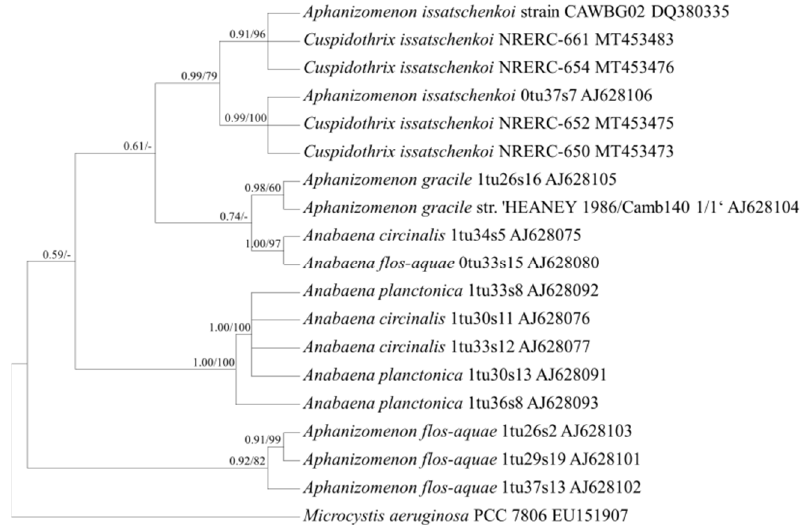
Figure 3. Consensus Bayesian tree based on aligned 499-bp sequences of rpoB using the GTR+G+I model with Microcystis aeruginosa as an outgroup. The parameters were as follows: assumed equal nucleotide frequency; substitution rate matrix with A–C substitutions = 0.0645, A–G = 0.2786, A–T = 0.0524, C–G = 0.1046, C–T = 0.4546, and G–T = 0.0451; proportion of sites assumed to be invariable = 0.2717; and rates for variable sites assumed to follow a gamma distribution with the shape parameter = 0.9189. The branch lengths are proportional to the amount of character changes. The numbers above the branches indicate the Bayesian posterior probability ( left ) and maximum-likelihood bootstrap values ( right ). Posterior probabilities ≥ 0.5 are shown.